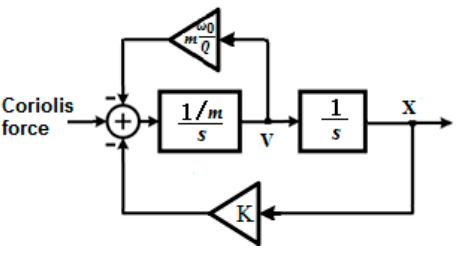
Figure 1. System level diagram of the dynamic system of a mechanical sensor.